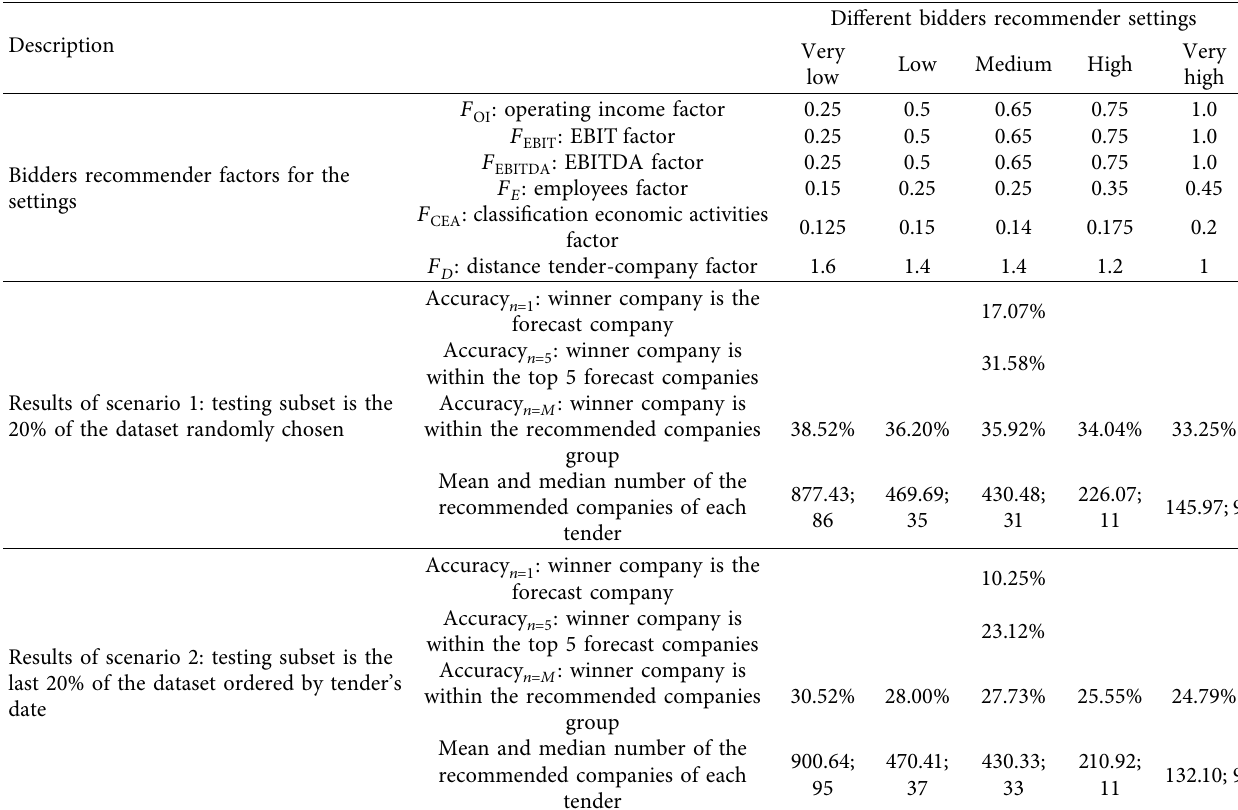
Table 5: Testing the bidders recommender for two scenarios: results of the accuracy and number of recommended companies per tender for five different setups.